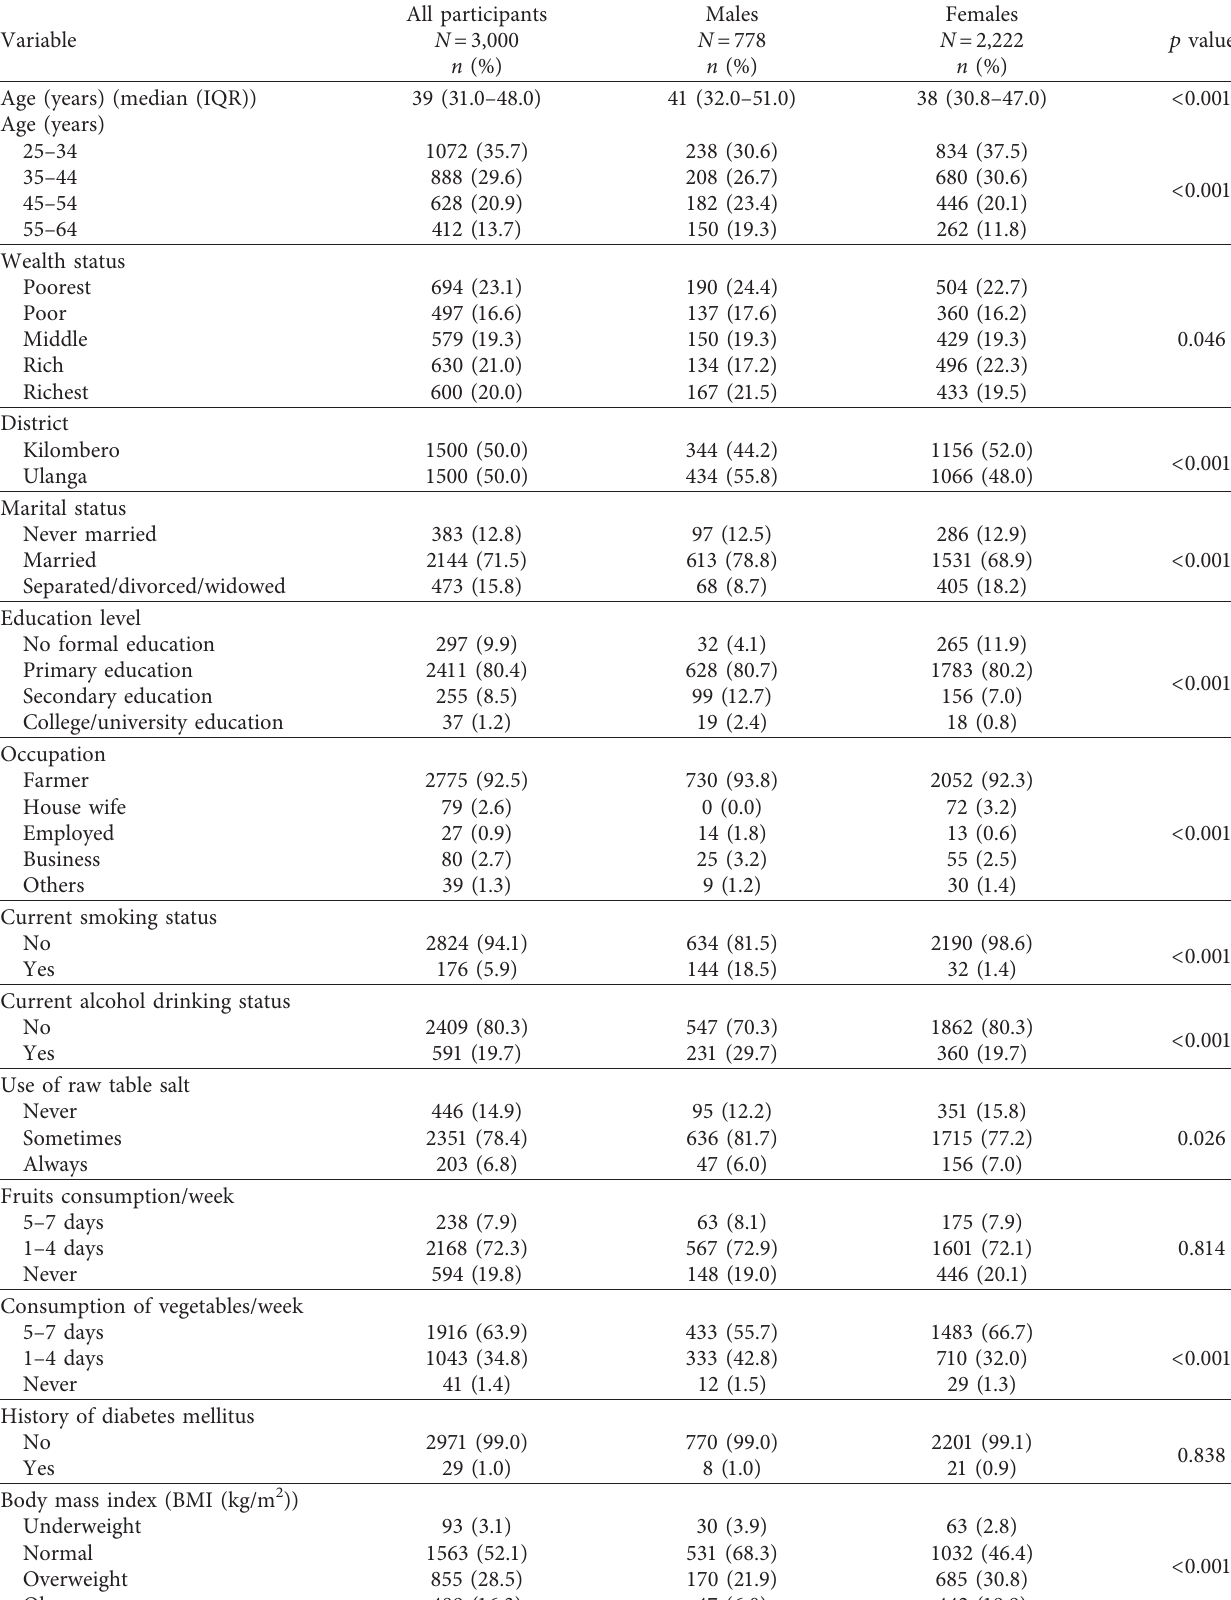
Table 1: Characteristics of the study